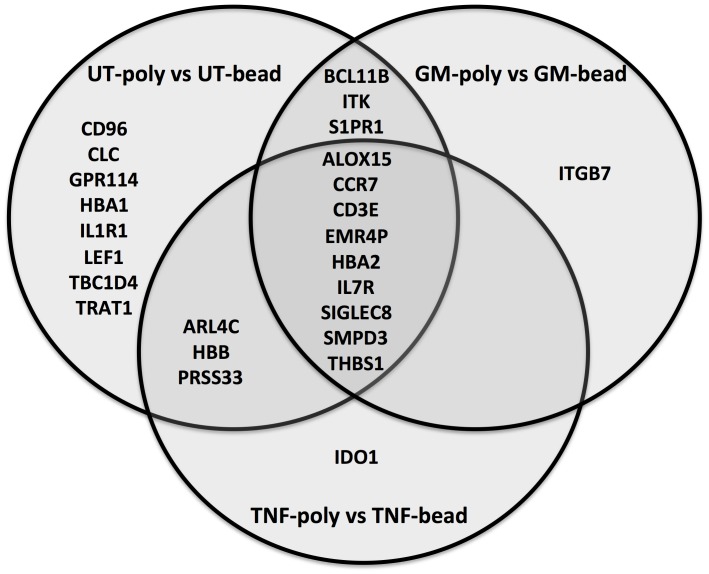
Venn diagram showing differentially expressed genes between neutrophil samples prepared by either Polymorphprep™ (poly) or magnetic beads (bead).Comparisons performed by Cufflinks using treatment specific paired-samples from two biological replicates. All genes displayed were significantly differentially expressed due to a higher RPKM in Polymorphprep prepared samples. Significance was calculated by Cuffdiff and adjusted for 5% false discovery rate by Benjamini-Hochberg correction for multiple-testing.